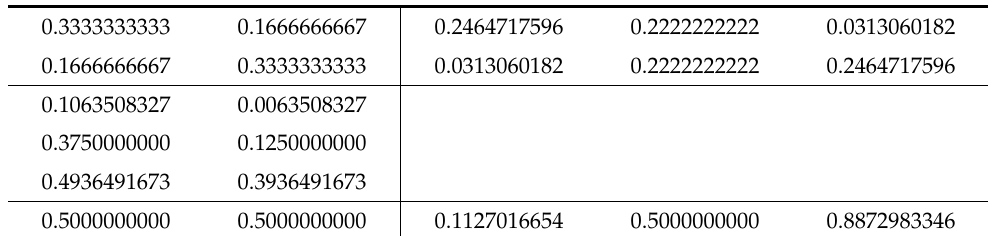
Table A22. L2|G3